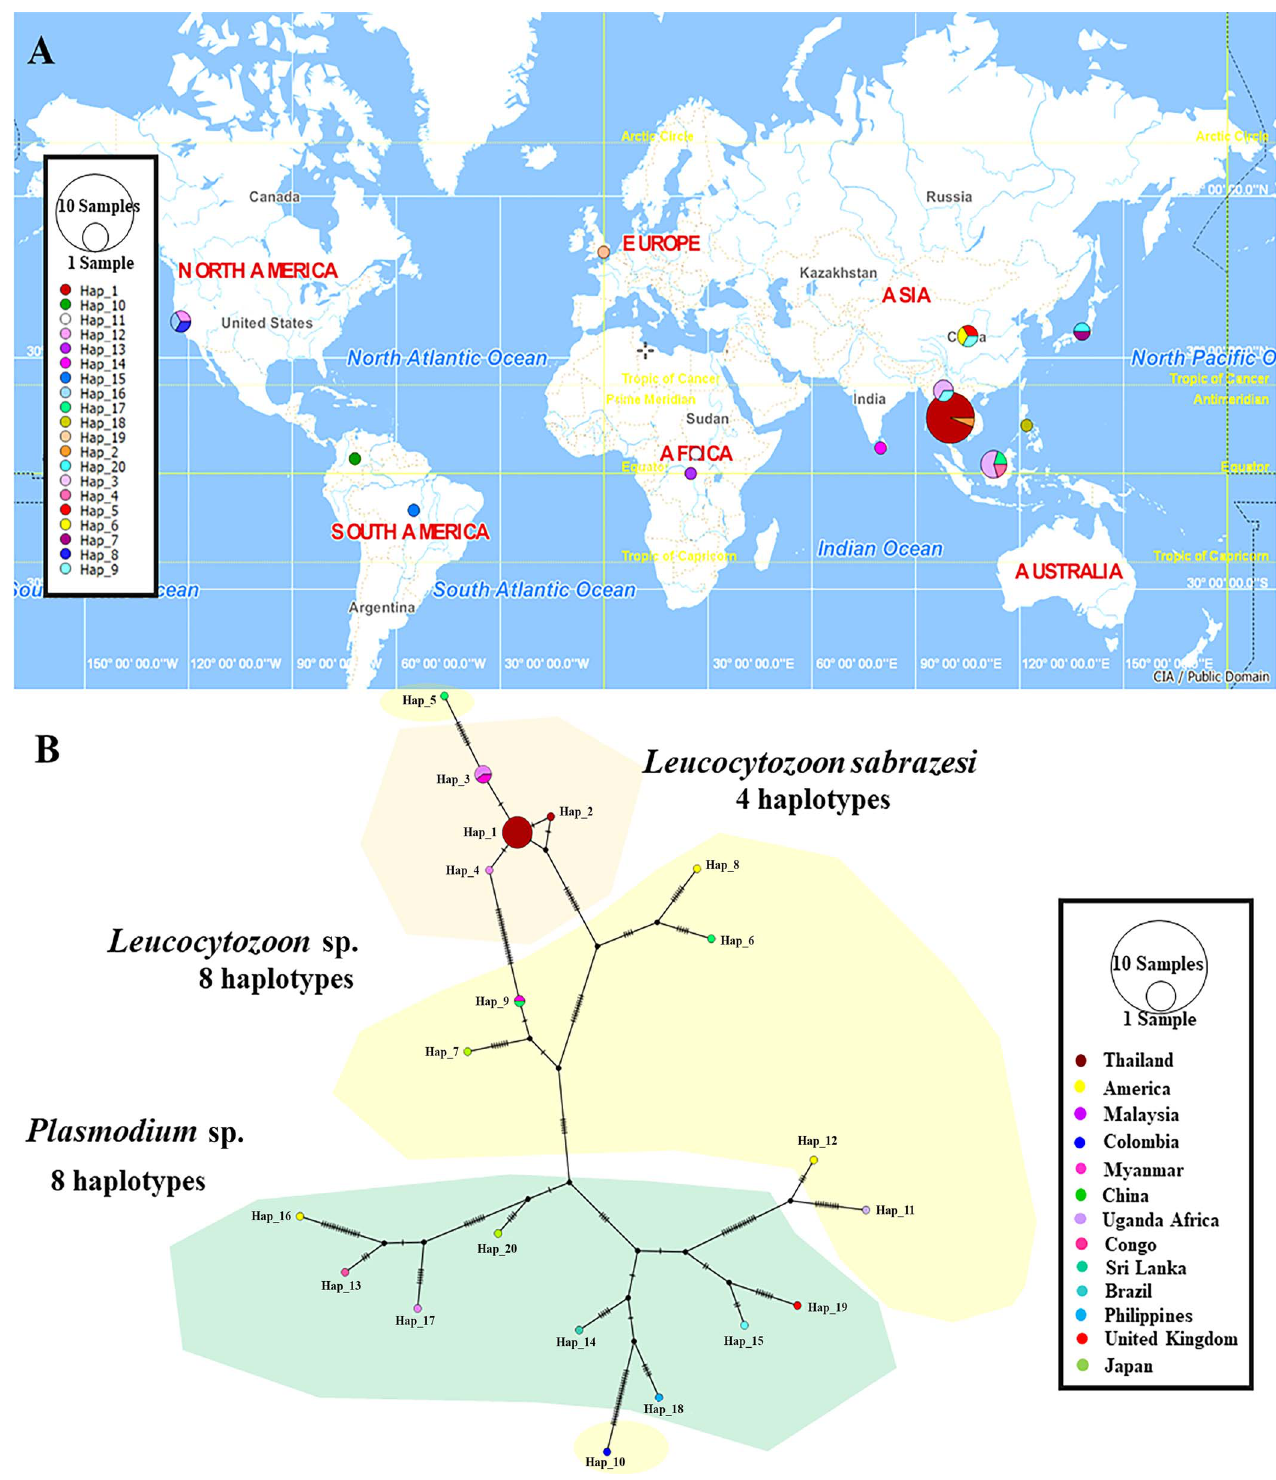
Fig. 7. TCS network of haplotypes based on Leucocytozoon spp. and Plasmodium spp. cytb gene sequences (A) detected in Thailand and other countries. The number of bars on lines between a haplotype and another represent the number of nucleotide mutation